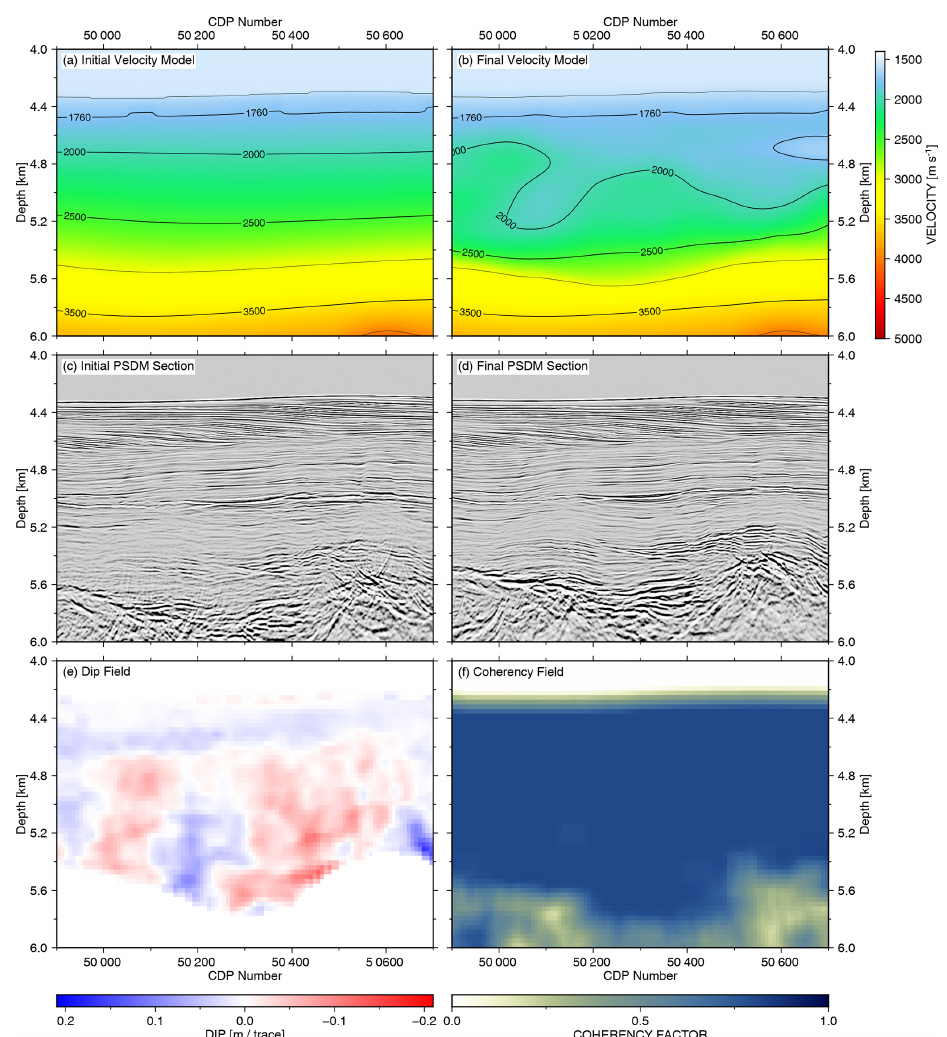
Figure 7. Depth tomography example A from Fig. 5, with CDP ranging from 46700 to 50800. (a) Initial velocity model merged from velocity analysis and wide-angle refraction tomography. (b) Final velocity model after five iterations of NRM-based depth tomography and PSDM. (c) PSDM result based on the initial velocity model. (d) PSDM result based on the final velocity model. (e) Reflector dip field calculated from the final PSDM result. (f) Reflector coherency field calculated from the final PSDM result. Note that “migration smile” artefacts at a depth of 5.6km in (c) are significantly reduced in the final PSDM result (d)